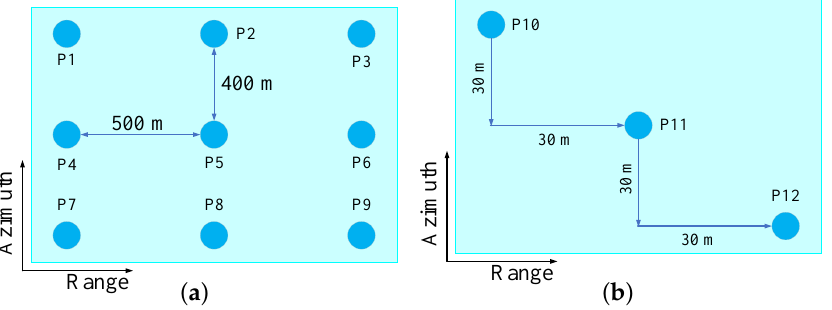
Figure 10. Geometry distribution of point targets in ground scene ( a ) for IETSA simulation, ( b ) for TFST simulation.